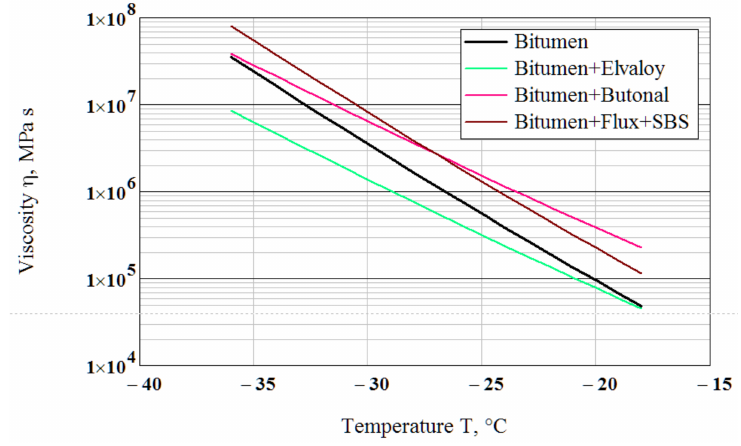
Figure 7. Viscosity–temperature relationships for the